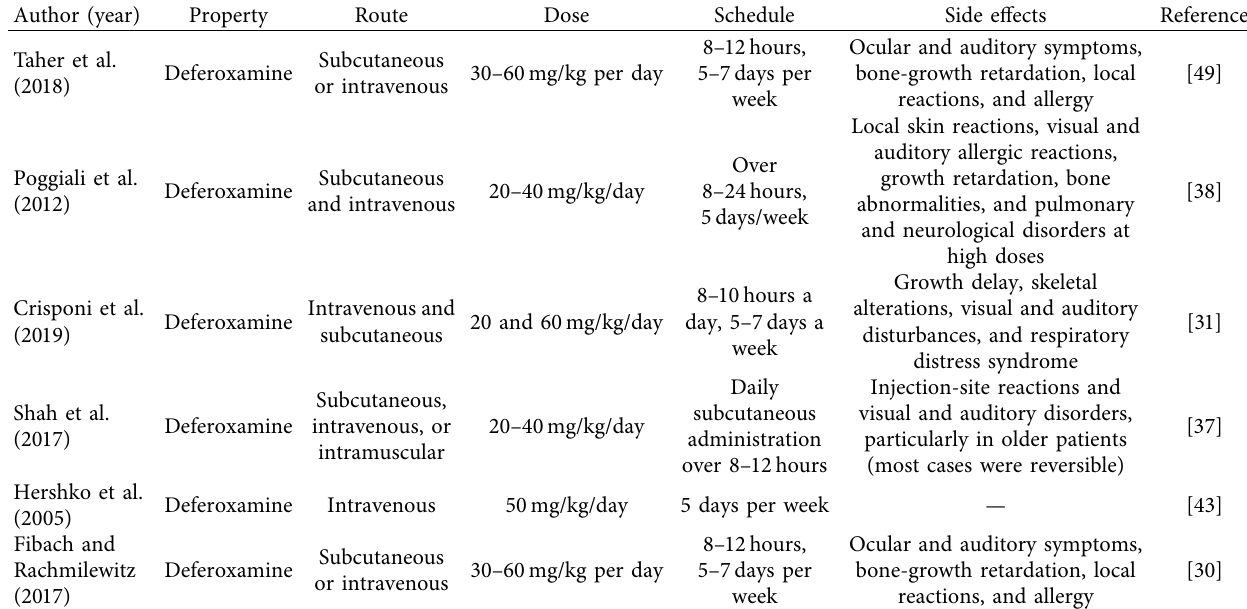
Table 1: Summary of the findings on